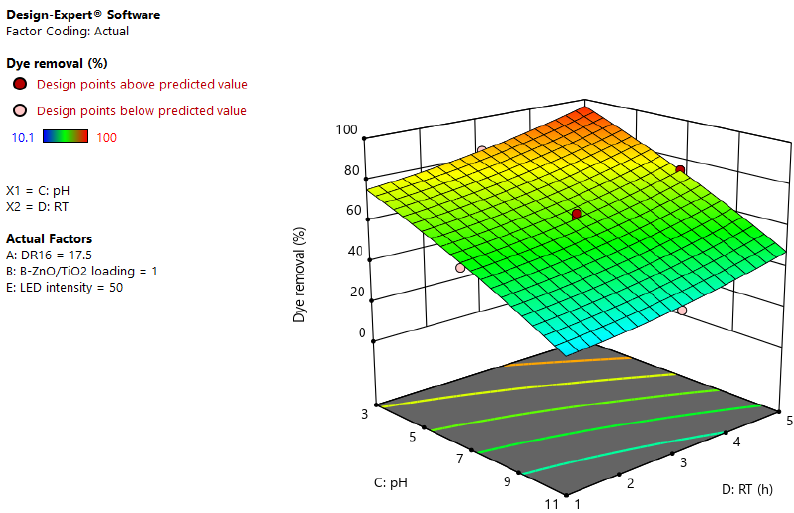
Figure 9. Three-dimensional surface plots of dye removal efficiency as a function of reaction time and pH at [DR16] = 17.5 mg/L, B-ZnO/TiO 2 loading = 1, and LED intensity = 50. The effects of reaction time and LED intensity on dye removal at [DR16] = 17.5 mg/L, B-ZnO/TiO 2 loading = 1, and pH = 7, are illustrated in Figure 10. By increasing the time from 1 to 5 h, the dye removal efficiency increased by about 15%, due to it having more time to react. A longer reaction and irradiation time led to the production of more reactive species, hence improving the dye removal efficiency.